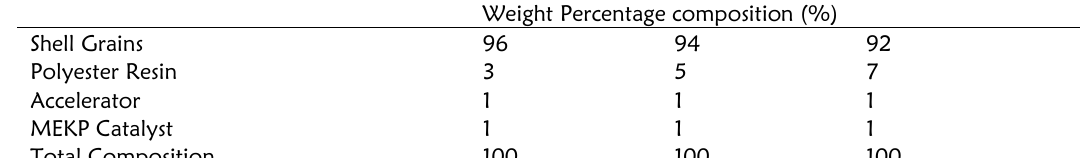
Table 1: Grains/resin composite formulation in batches